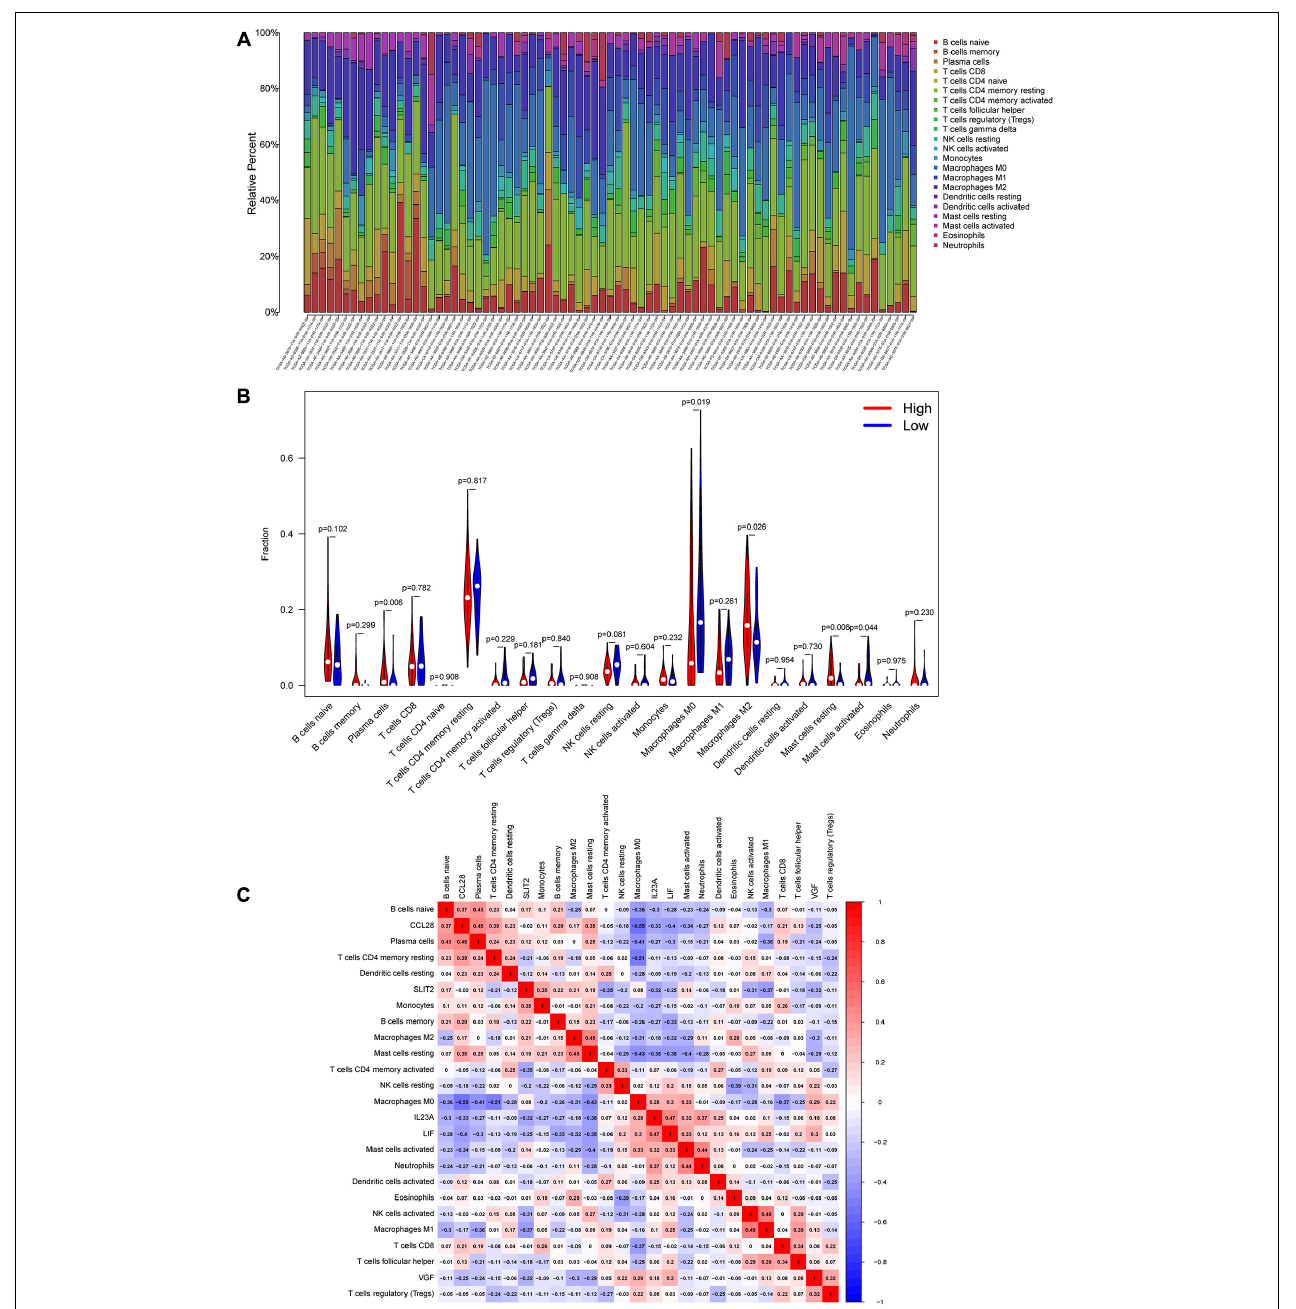
FIGURE 6 | Correlation between the six immune genes in IRGCRCII and immune cell infiltration. The percentage stacked bar chart shows the distribution of the 22 immune cells in the stage II CRC samples from TCGA (A) . The violin plots present differences in the abundance of immune cells between the high-risk and low-risk groups. Blue represents the low-risk group, while red represents the high-risk group (B) . Correlation matrix of the six immune genes with 22 tumor-infiltrating immune cells. Red represents a positive correlation, while blue represents a negative correlation (C) . p < 0.05. CRC, colorectal cancer; TCGA, The Cancer Genome Atlas.